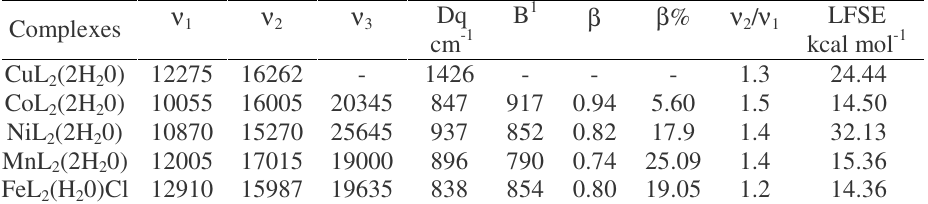
Figure 3 . Probable structure of Fe(III) complex of the ligand ClTHS. Table 2. Electronic spectral data and ligand field parameters of Cu(II), Co(II) , Ni(II) and Fe(III)